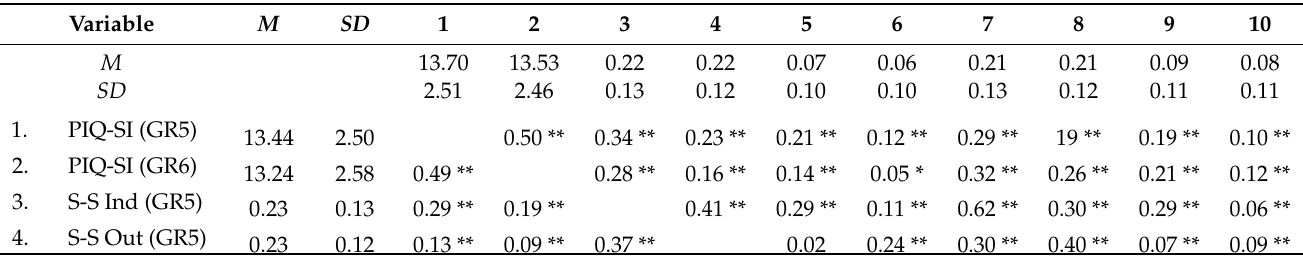
Table 1. Means, standard deviations, and